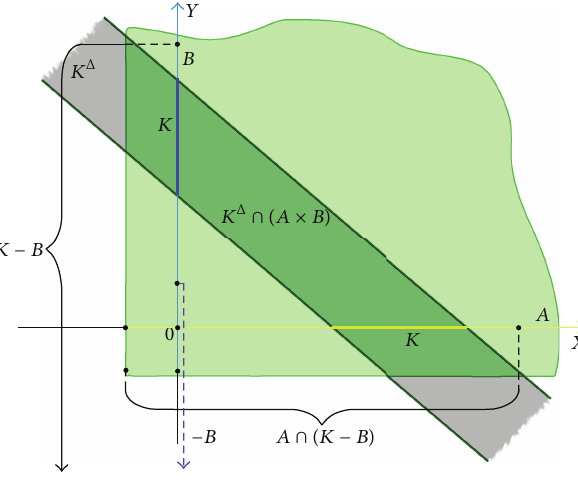
Figure 1: Compatible